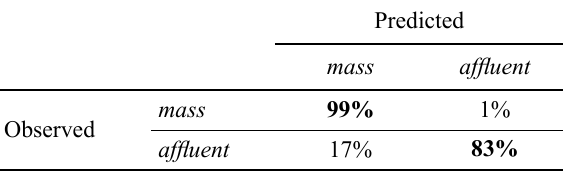
Table 5. Confusion Matrix for Test sample using